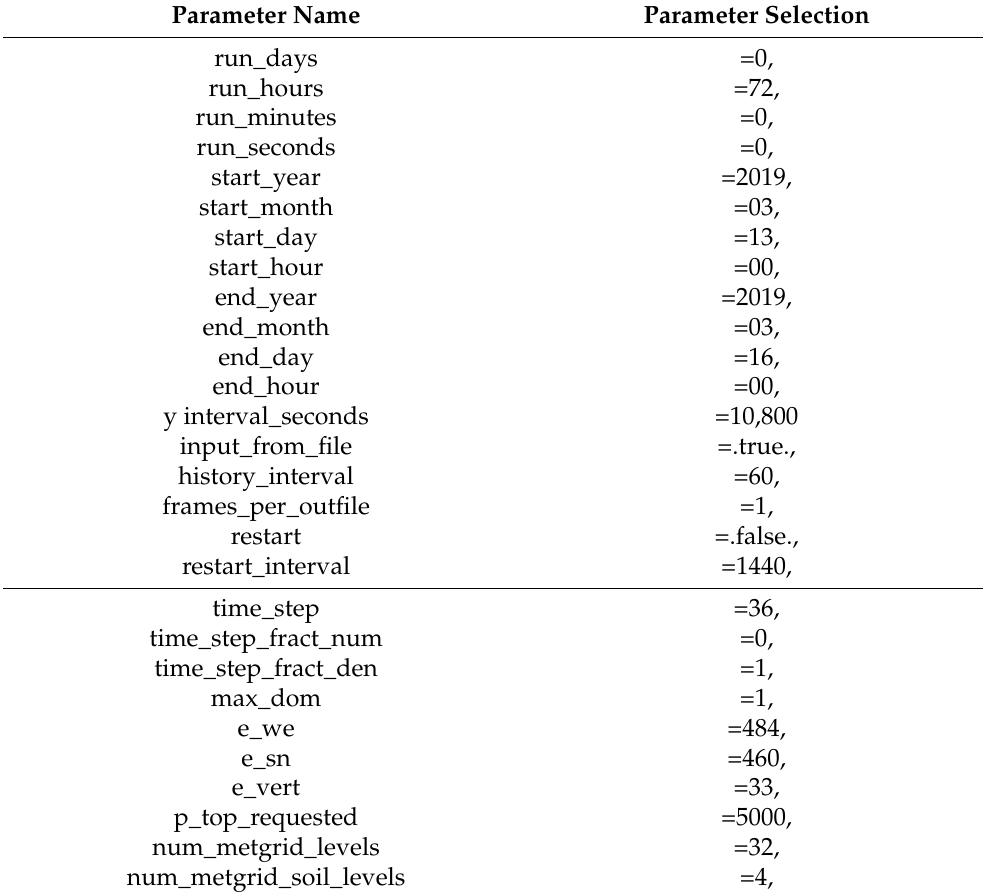
Table A1. This is a table caption. Tables should be placed in the main text near to the first time they are